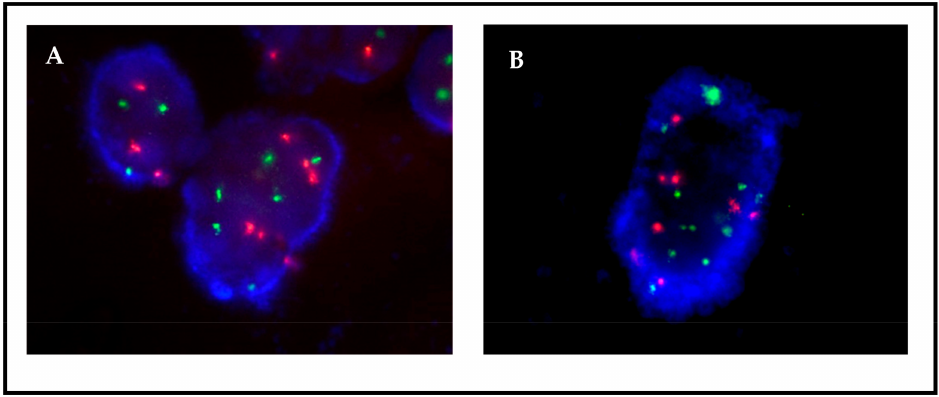
Figure 5. Patient 1, FISH MET on passage 13 ( A ) without HGF and ( B ) with HGF. MET gene copies are observed as green signals. A CNG pattern corresponding to ≥ 5 green signals is more frequently detected in the presence of